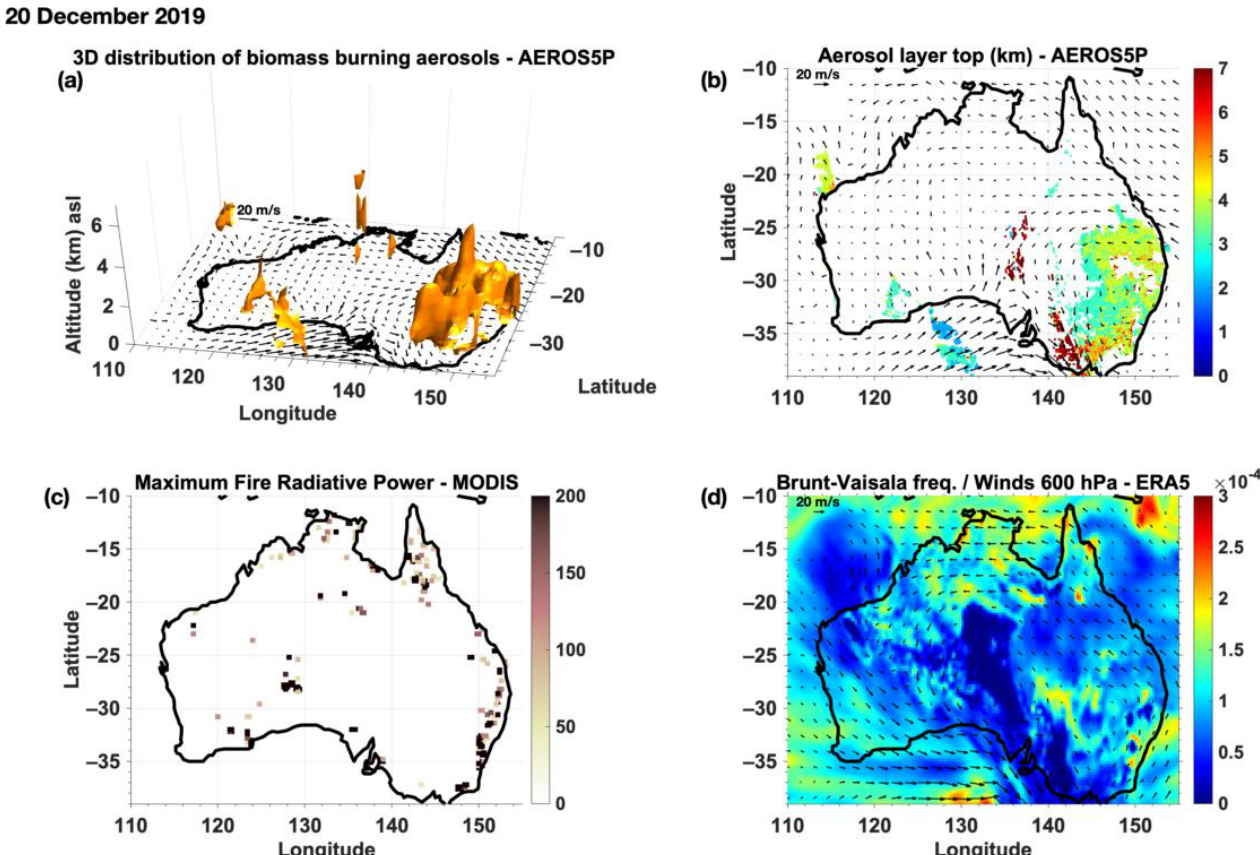
Figure 6. ( a ) Three-dimensional distribution of biomass burning aerosols on 20 December 2019 de- rived from TROPOMI measurements using the AEROS5P method, depicted as iso-aerosol extinc- tion surface of 0.1 km −1 . ( b ) Aerosol layer top derived from AEROS5P as the aerosol highest layer with aerosol extinction larger than 0.1 km −1 . ( c ) Maximum fire radiative power derived from MODIS sensors onboard Aqua and Terra within each 0.2 × 0.2° grid pixel. ( d ) Static atmospheric stability depicted by the Brunt – Vaisala frequency derived from ERA5 reanalysis. Winds from ERA5 reanal- ysis are overlaid on panels ( a , b ) at 850 hPa and ( d ) at 600 hPa. For clarity, wind speed scales are shown in the upper left corners and wind vectors are displayed for each 1.5 × 1.5° grid point.